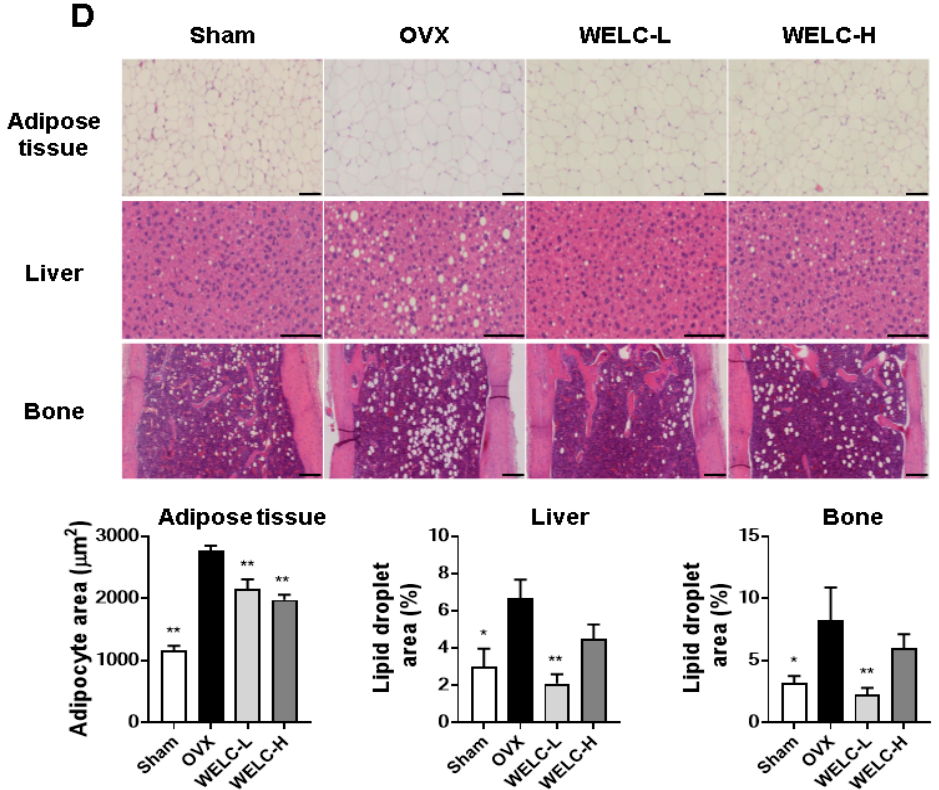
Figure 4. Inhibitory effects of WELC on OVX-induced fat accumulation. Sham or OVX mice were administered vehicle, WELC-L (100 mg / kg), or WELC-H (300 mg / kg) for five weeks. ( A ) Body weight gain during the experimental period, ( B ) uterine weight, and ( C ) gonadal fat weight were measured. ( D ) Histological analysis of adipose tissue, liver, and bone was performed using hematoxylin and eosin staining (scale bar, 100 µ m). Image analysis of the adipocyte area or lipid droplets in each tissue was performed using the ImageJ program. * p < 0.05, ** p < 0.01 versus OVX group. WELC, water extract of Lysimachia christinae ; OVX, ovariectomized.